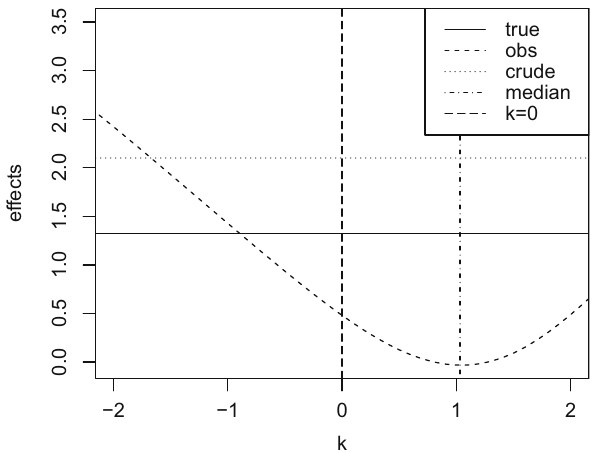
, μ 2 , β 0 = , γ 1 = , 0 = 1 =